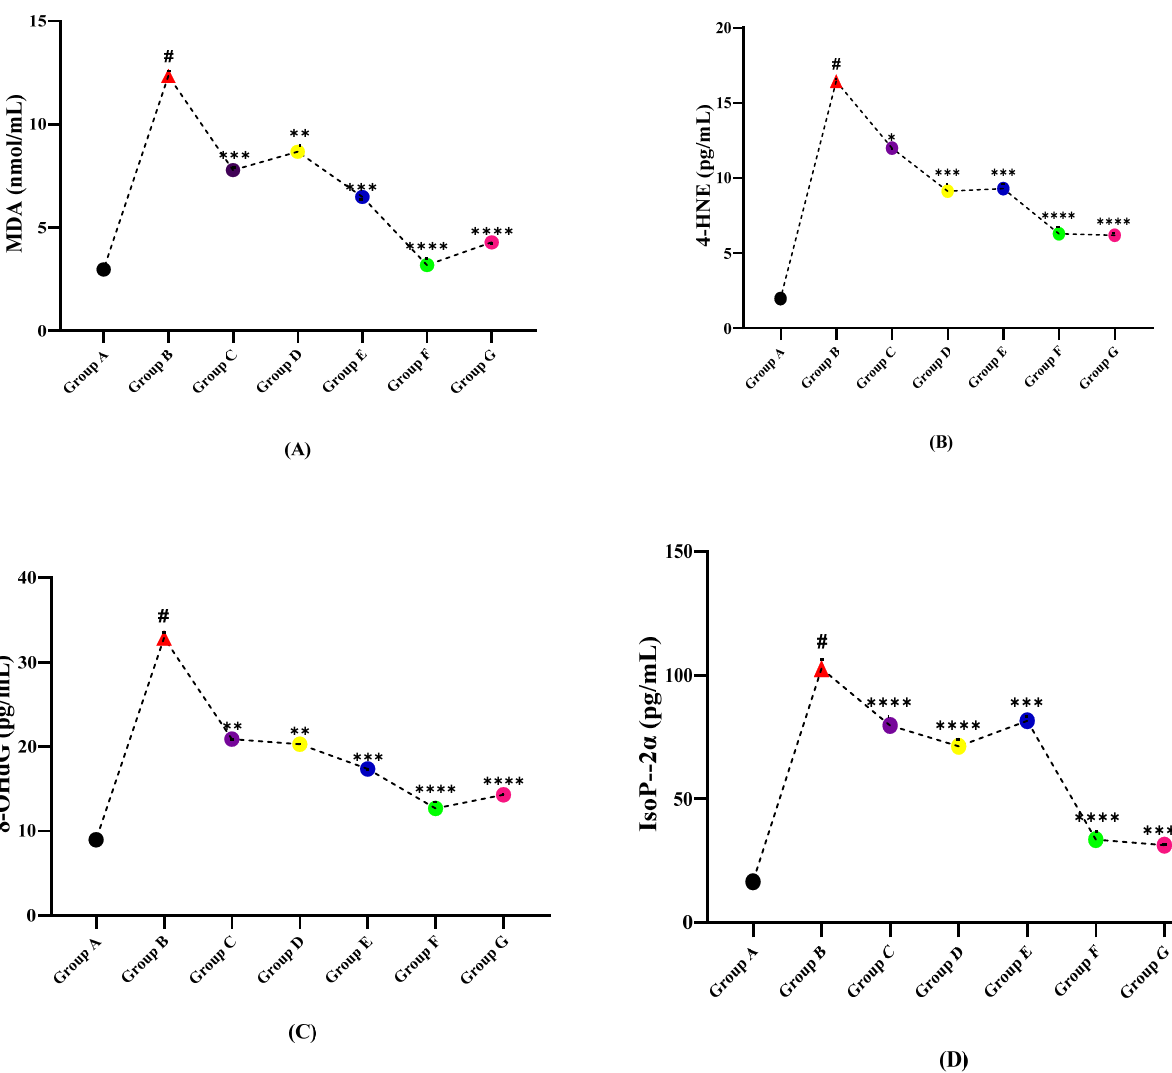
Figure 4. Comparison of plant extracts treated groups independently against LPS induced multiple sclerotic Wistar rats ( A ) MDA, ( B ) 4-HNE, ( C ) 8-OHdG, and ( D ) Iso5P-2 α . (# indicate reference group EAE model while Asterisks are showing the significance in the improvement of results as compared to reference group B). (*) slight significance, (**) moderate significance, (***) high significance, (****) very highly/effective significance.